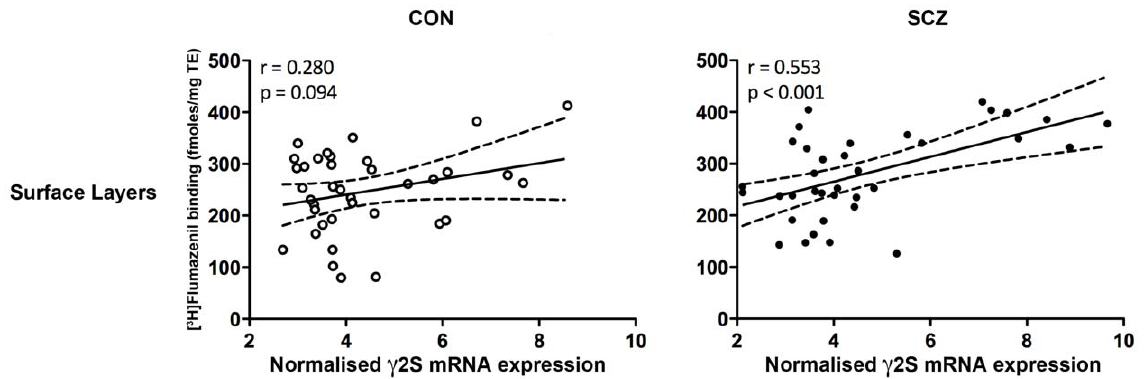
Figure 5. Correlations of [ 3 H]Flumazenil binding and c 2S mRNA subunit expression level in the superficial layers of the DLPFC of control (CON) (n=37) and schizophrenia (SCZ) (n=37)